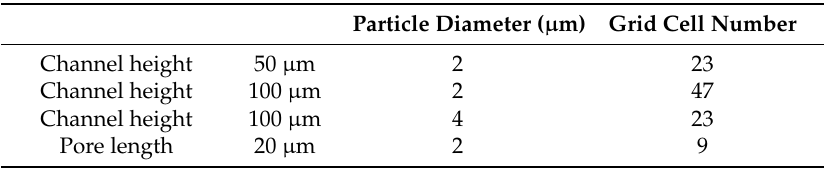
Table 3. Overview of the different dimensions used in the parameter studies.